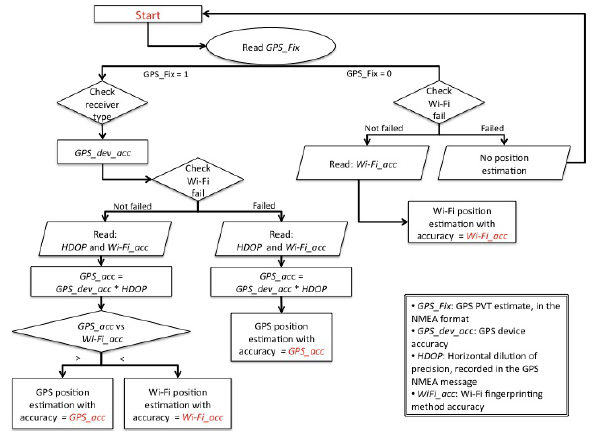
Figure 4: Algorithm for the combination of GPS and Wi-Fi posi-